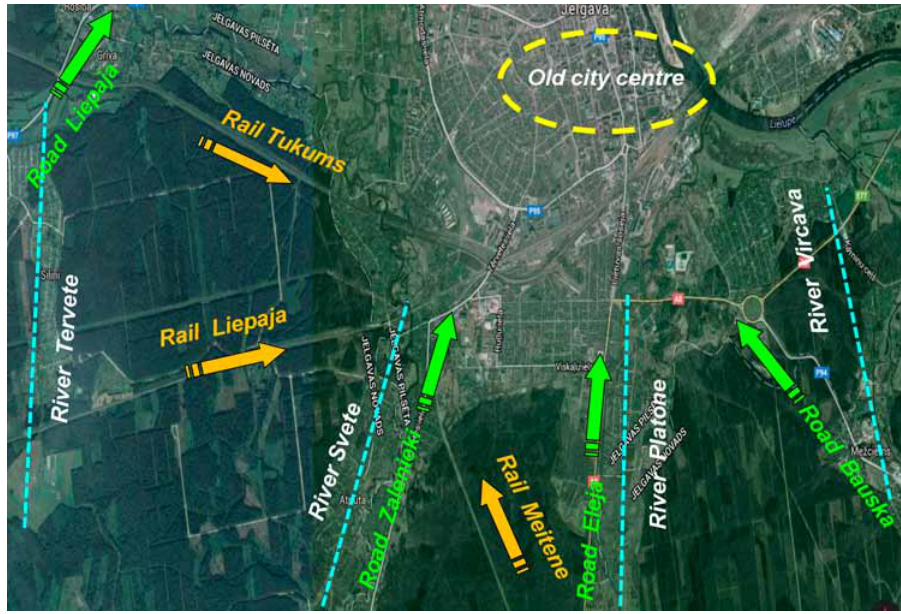
fig. 2. Motorways, rail tracks and river networks, which in the in the 70s of the 19 th century form the structure of the urban